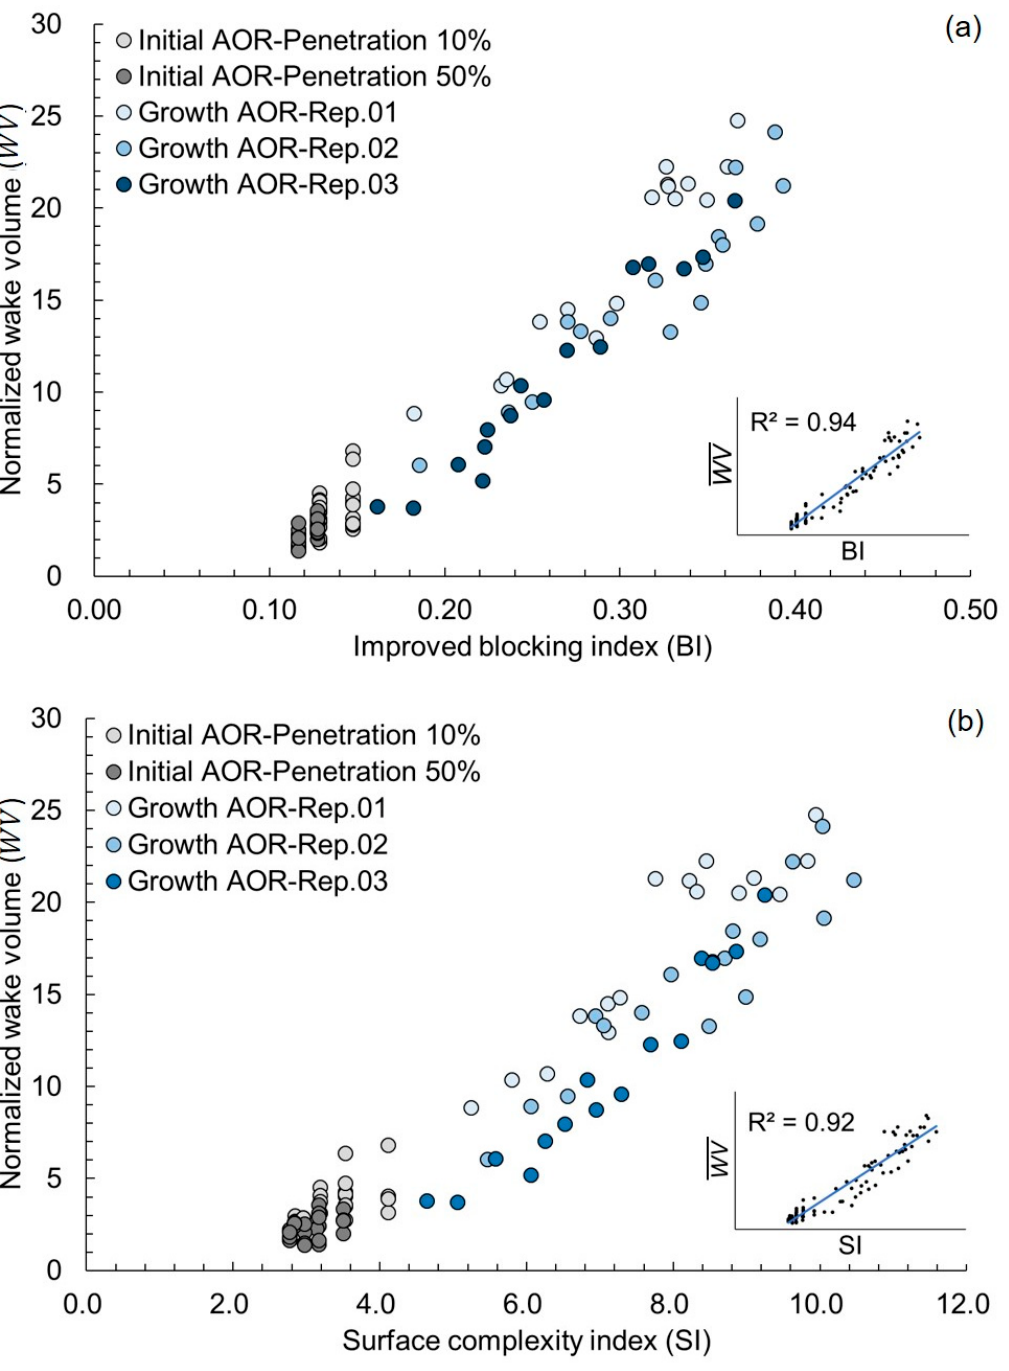
Figure 10. Normalized wake volume ( WV ) according to ( a ) the improved blocking index (BI) and ( b ) the surface complexity index (SI).